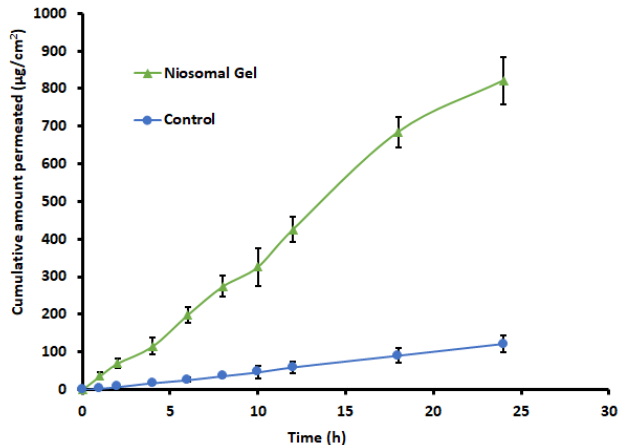
Figure 11. Ex vivo permeation pro fi les of levosulpiride from niosomal gel and control gel across rat skin. Each value depicts the mean and standard deviation of six di ff erent batches.